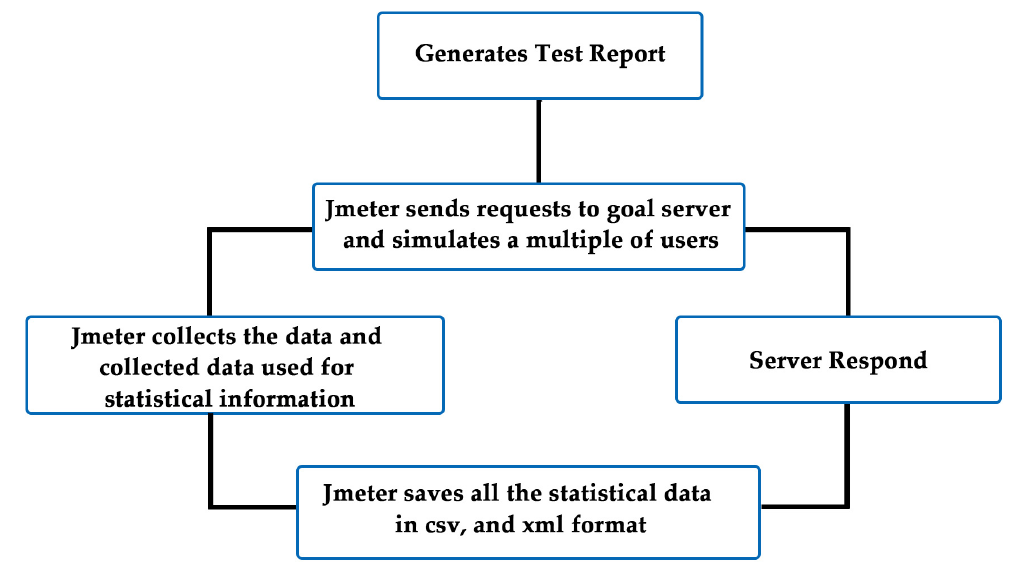
Figure 7. Workflow diagram of Apache Jmeter.